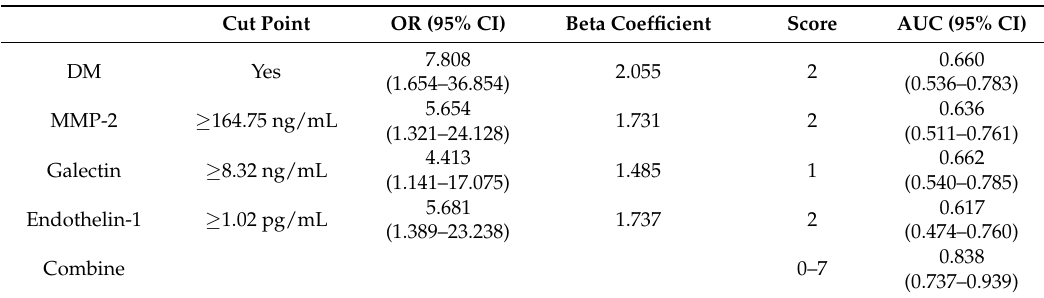
Table 3. Scoring system and area under curve (AUC) to predict the degree of myocardial diffuse fibrosis by using median values as cut-off